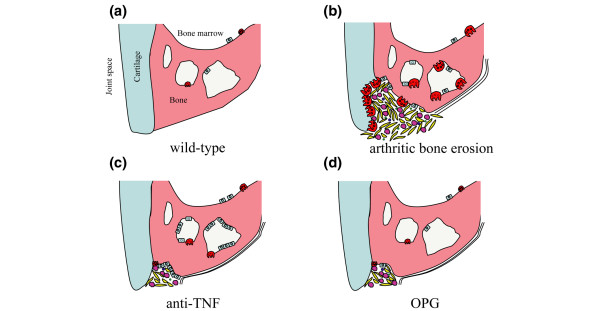
Overview on local bone turnover in tumor necrosis factor transgenic mice. (a) Schematic overview of a healthy joint with only scarce osteoblasts (cubic-shaped blue cells) and osteoclasts (multinucleated red cells) in cortical bone channels and the endosteal bone surface. (b) In arthritis, synovial inflammatory tissue comprised of synovial fibroblasts (yellow spindle-shaped cells), macrophages (purple cells), T cells (green cells), B cells (dark blue cells) and other cells invade the subchondral bone and trigger massive local osteoclastogenesis and – as a reactive process – osteoblastogenesis. Also, osteoclast and osteoblast accumulation occurs in cortical bone channels but not at the endosteal bone surface distant from synovitis. (c) TNF blockade efficiently diminishes bone erosion and suppresses osteoclastogenesis in subchondral bone erosions and cortical bone channels. In contrast, enhanced osteoblast activity can be detected in both regions, suggesting an increased reparative response when TNF is blocked. (d) Receptor activator of NF-κB ligand blockade inhibits bone erosion but not synovitis. Osteoclastogenesis is efficiently blocked in all compartments but, in contrast to anti-TNF, osteoblasts are also massively reduced. OPG, osteoprotegerin.